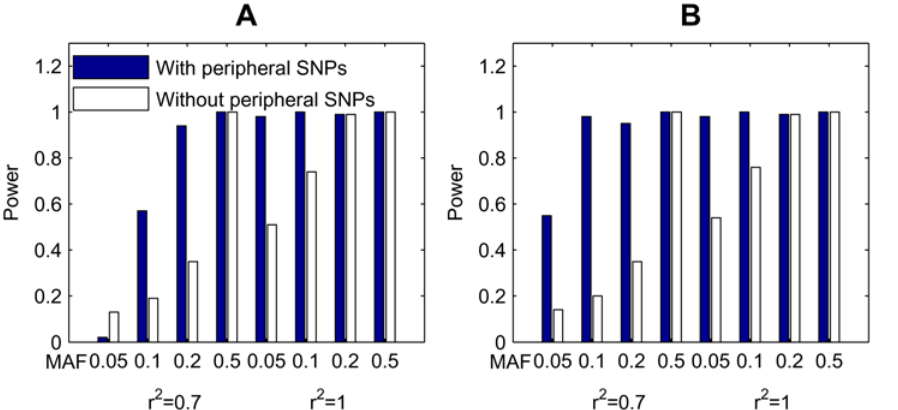
Figure 4. Performance of epi MODE on disease models with and without peripheral SNPs. (A) Results of the selection-testing-correction approach. (B) Results of the permutation test method. The original model 5 is used as the disease model without peripheral SNPs. The extended model 5 in which each of the two core SNPs has a peripheral SNPs is used as the disease model with peripheral SNPs.